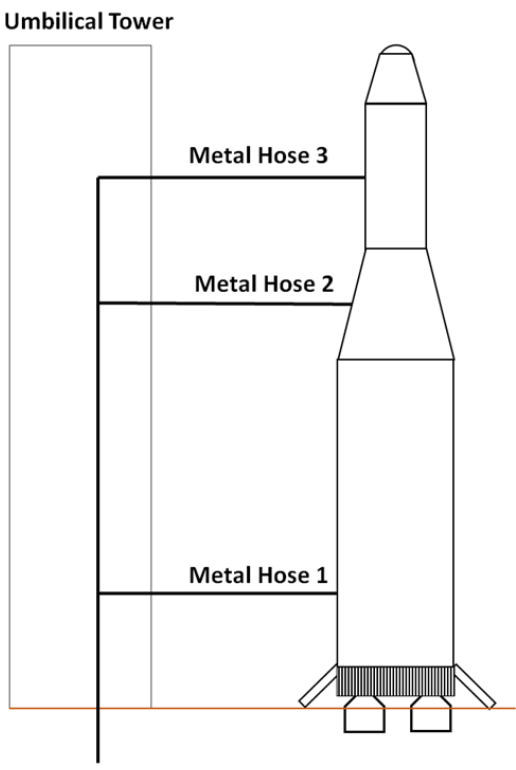
Figure 2. Schematic of metal hoses connecting the rocket to the umbilical tower.